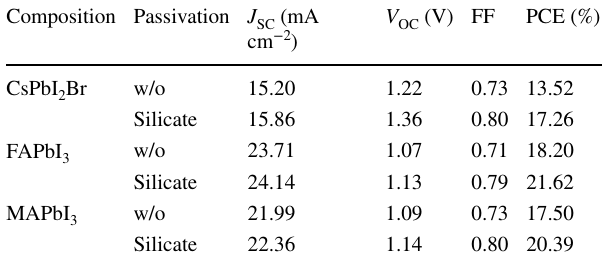
Table 1 Photovoltaic parameters of the champion PSCs based on dif- ferent perovskite compositions